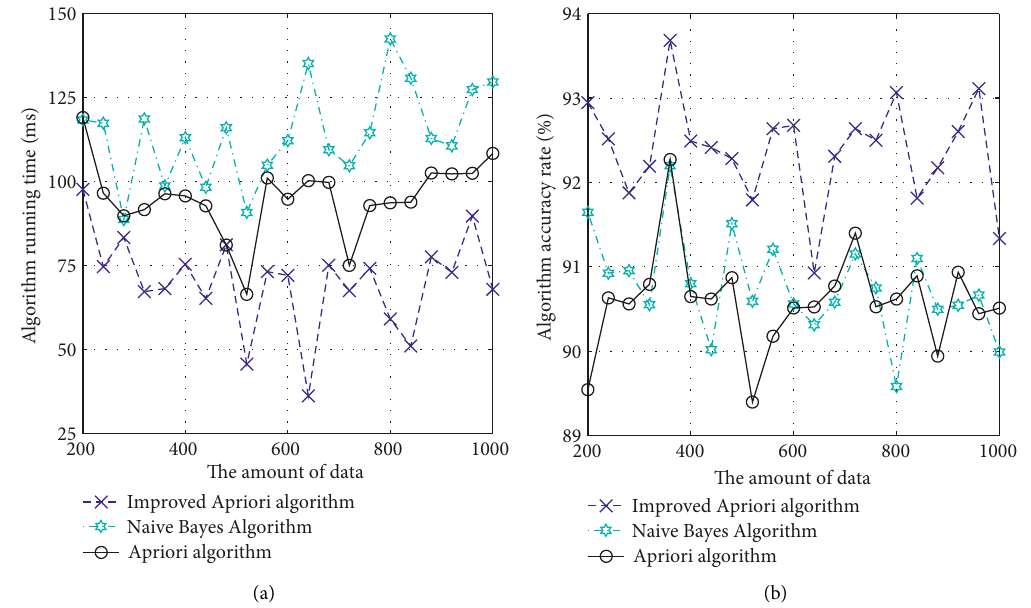
Figure 6: Comparison of the running time of the algorithm and the accuracy of the algorithm. (a) Comparison chart of the running time of the algorithm, (b) Comparison chart of the accuracy of the